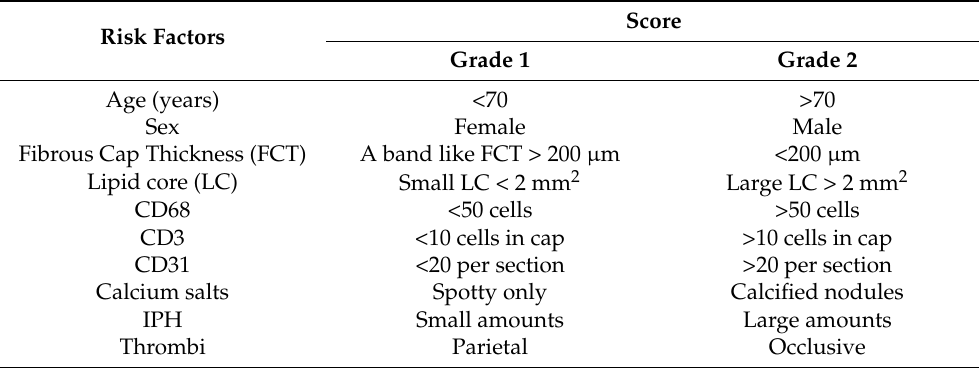
Table 1. Two grades of the proposed plaque instability index were determined by assessing clinical and histological risk factors.